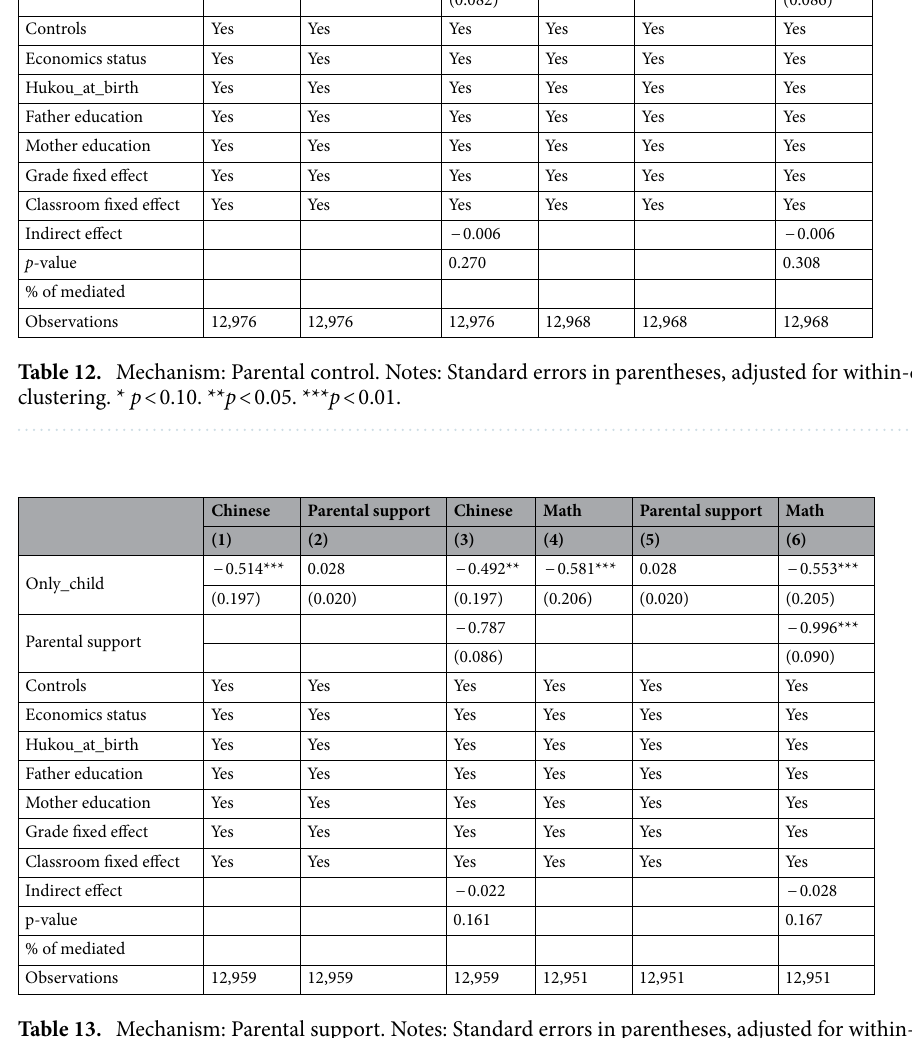
Table 13. Mechanism: Parental support. Notes: Standard errors in parentheses, adjusted for within-classroom clustering. * p < 0.10. ** p < 0.05. *** p <